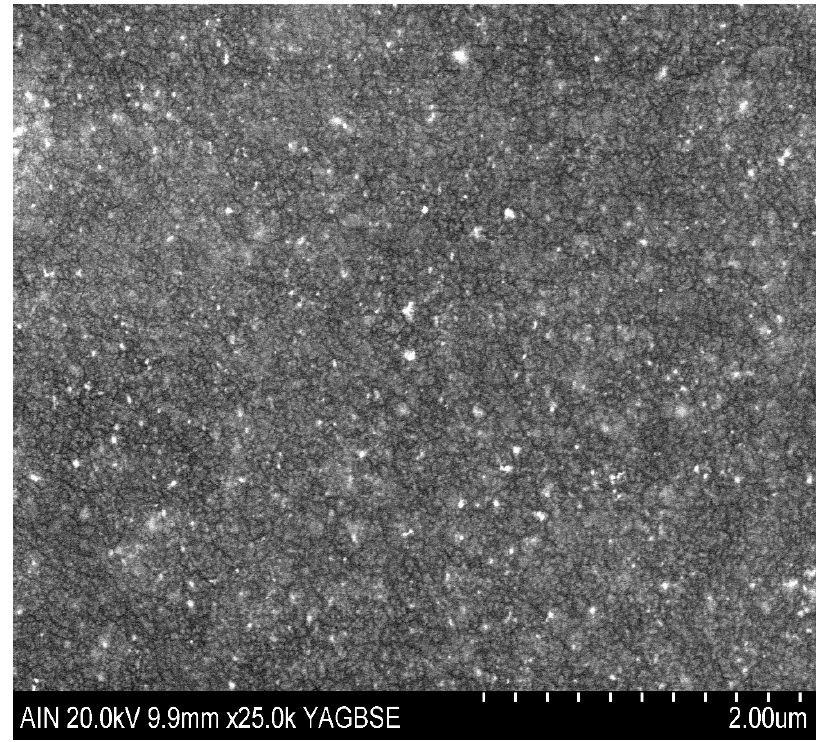
Figure 4. Backscattered electron image of the resultant surface morphology of the LbL coating composed of both types of nanoparticles (AgNPs and AuNPs, respectively). The light spots correspond to the metallic NPs.